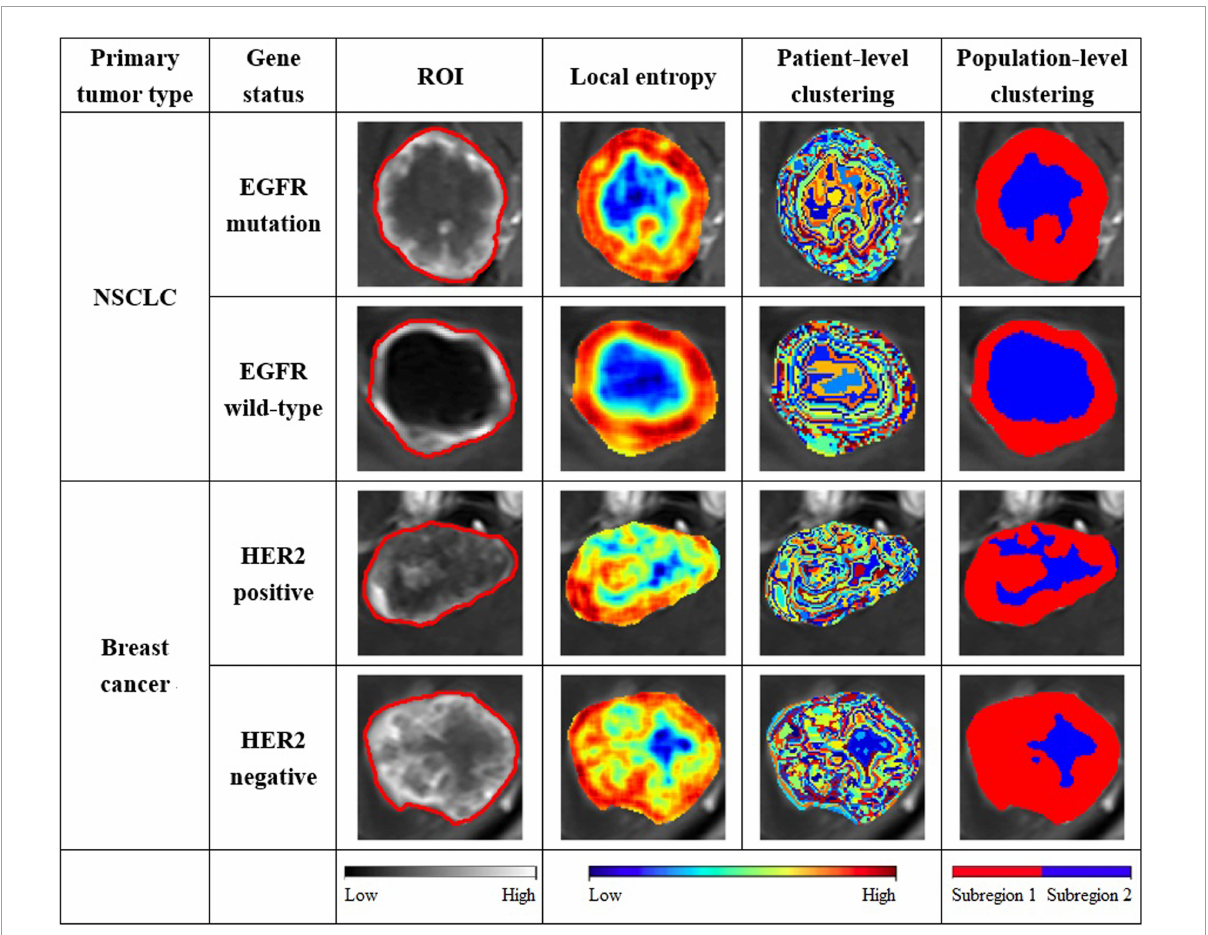
FIGURE3 Intratumoral partitions in the MRI images of patients with brain metastasis. The third column represents ROIs in the MRI image. The fourth column represents local entropy maps within the tumor. The fifth column represents the results of patient-level clustering. The sixth column represents the results of population-level clustering.